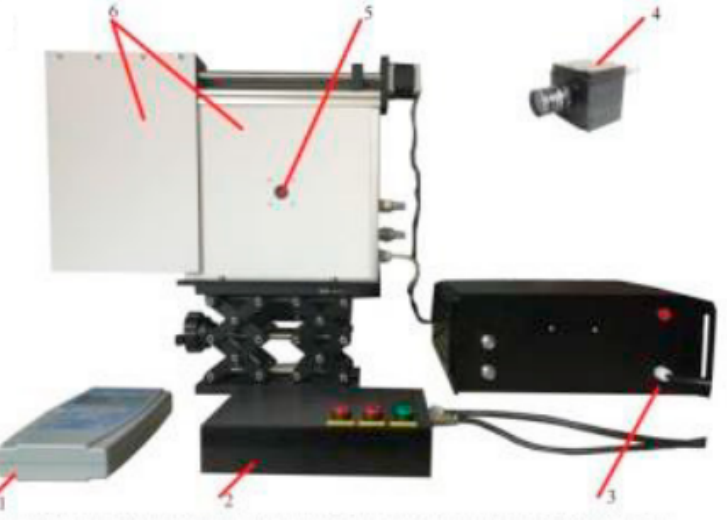
Figure 4. Heat flux measurement system.